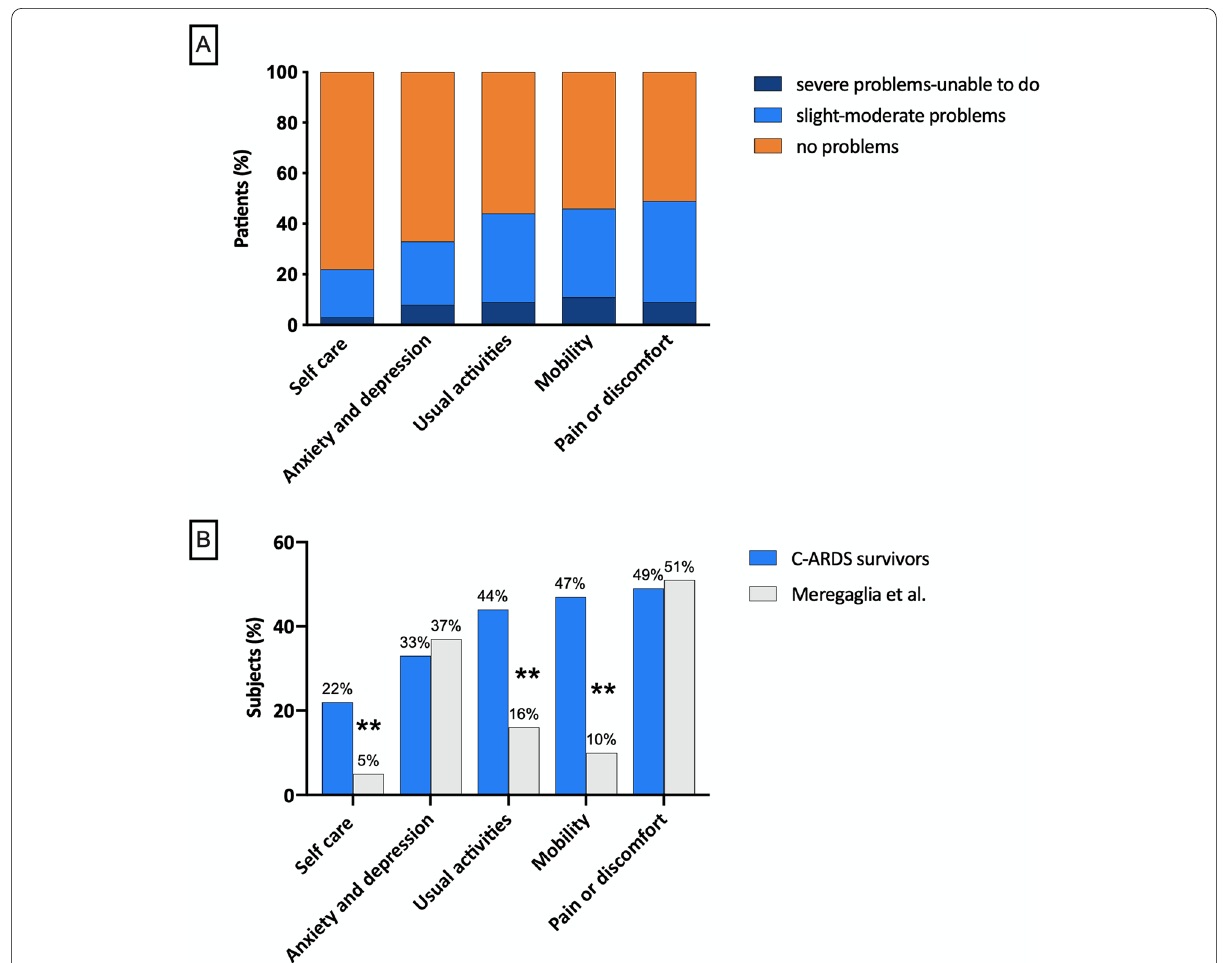
Fig. 2 Health-related quality-of-life scale (EQ-5D-5L) in C-ARDS survivors. A Frequency distribution of the EQ-5D-5L scores in each of the five domains (pain or discomfort, mobility, usual activities, anxiety, and depression, self-care). Each domain is scored on a 5-point scale: 1 no problems, 2 slight problems, 3 moderate problems, 4 severe problems, and 5 unable to do. Scores are grouped in three classes: no problems, slight to moderate problems, and severe problems or unable to do. B EQ-5D-5L domain scores for patients responding at the structured interview compared to Italian norm data. Data represent the percentage of subjects and patients with problems of any level (2 to 5 in each of the five domains). Significant differences between C-ARDS survivors ( N 79) and age-matched Italian subjects [30] ( N 211) were analyzed using Fisher’s exact test. ** p < = =